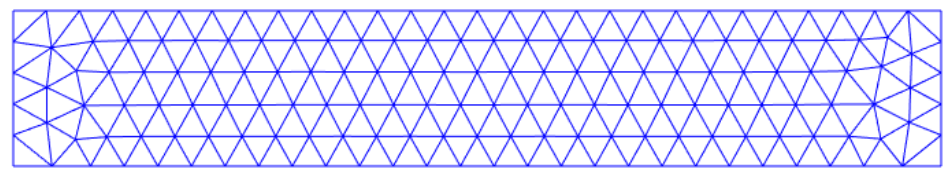
Figure 14. Part with uniform infill density of 22%. Table 5. FE simulation results of part with uniform infill